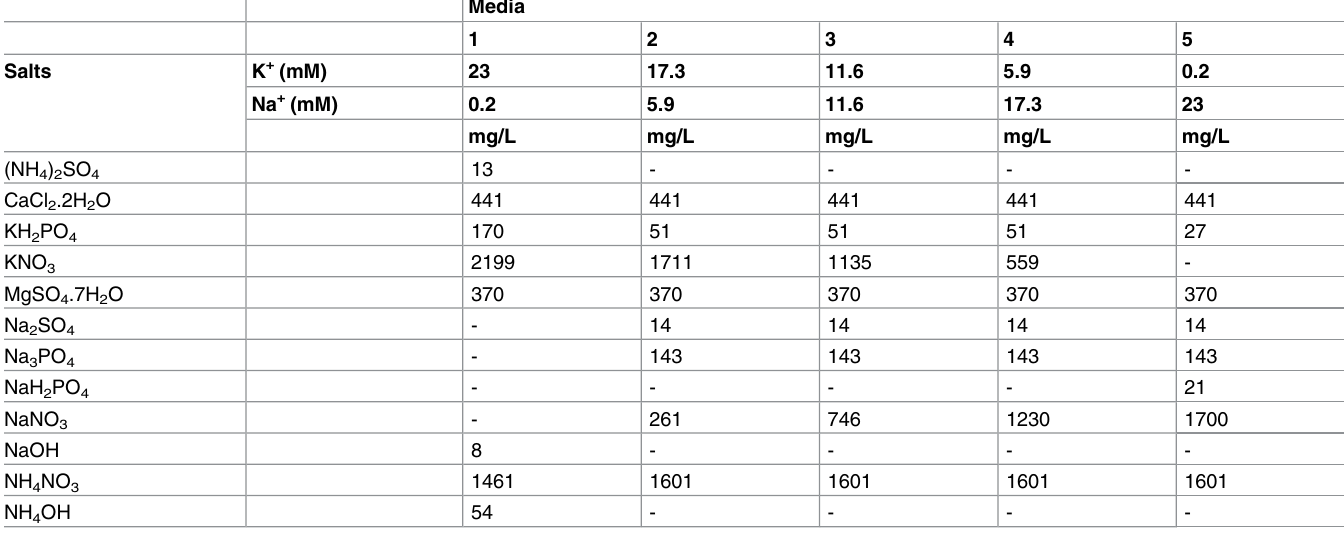
Table 4. Recipes generated by ARS-Media for Excel for the 5 media listed in Table 2. In addition to the salts listed, all recipes included the MS salts that deliver Fe 3+ , Mn 2+ , Zn 2+ , BO 33- , I - , Cu 2+ , MoO 42- , and Co 2+ as follows: FeSO 4. 7H 2 O, Na 2 EDTA . 2H 2 O, MnSO 4. 4H 2 O, ZnSO 4. 4H 2 O, H 3 BO 3 ,